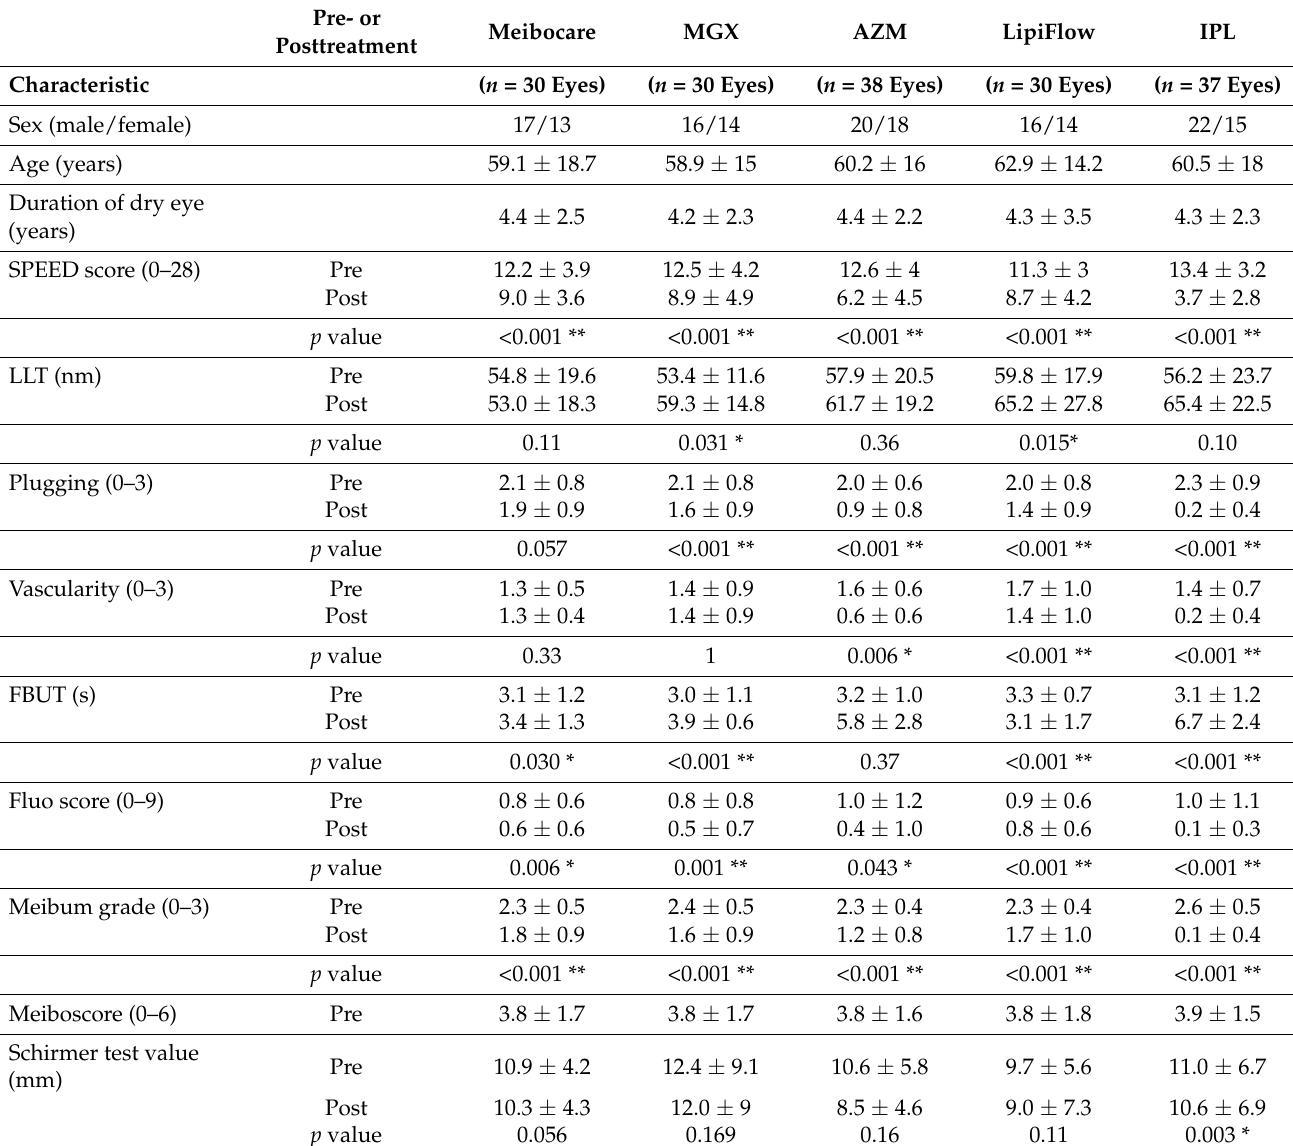
Table 1. Characteristics of the study subjects with meibomian gland dysfunction before and after treatment in the meibocare, meibomian gland expression (MGX), azithromycin eyedrop (AZM), LipiFlow, and intense pulsed light (IPL) groups.